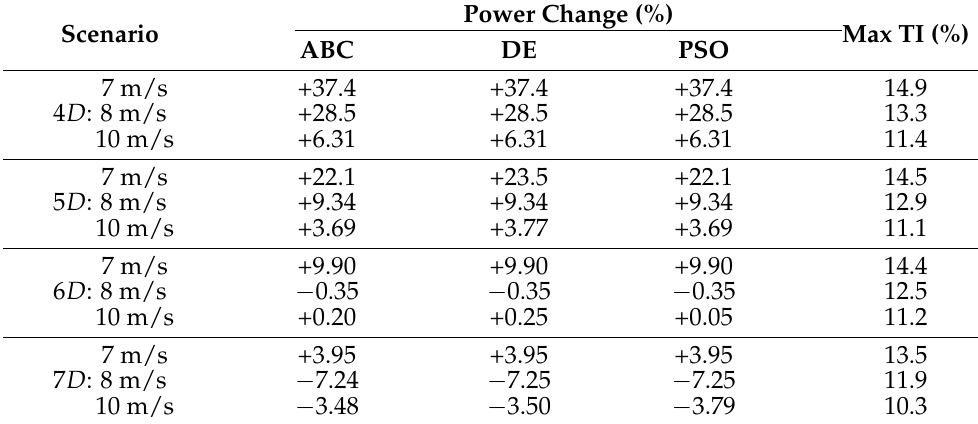
Table 7. MWZ and wind plant power increments with averaged TI decrements in comparison with base case (Base) for all scenarios.